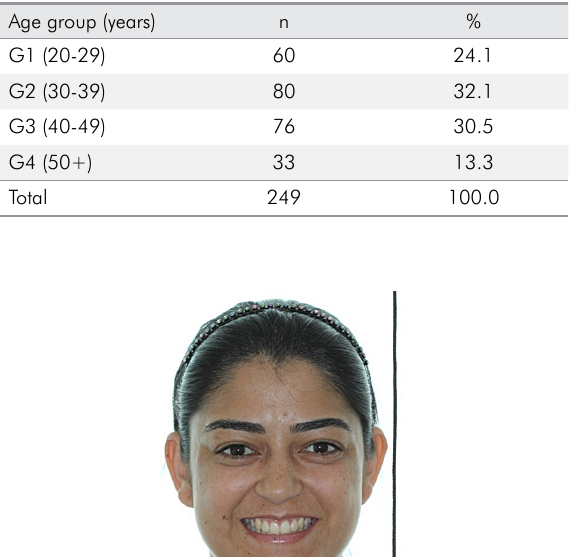
Table 1. Description of the sample (age groups).